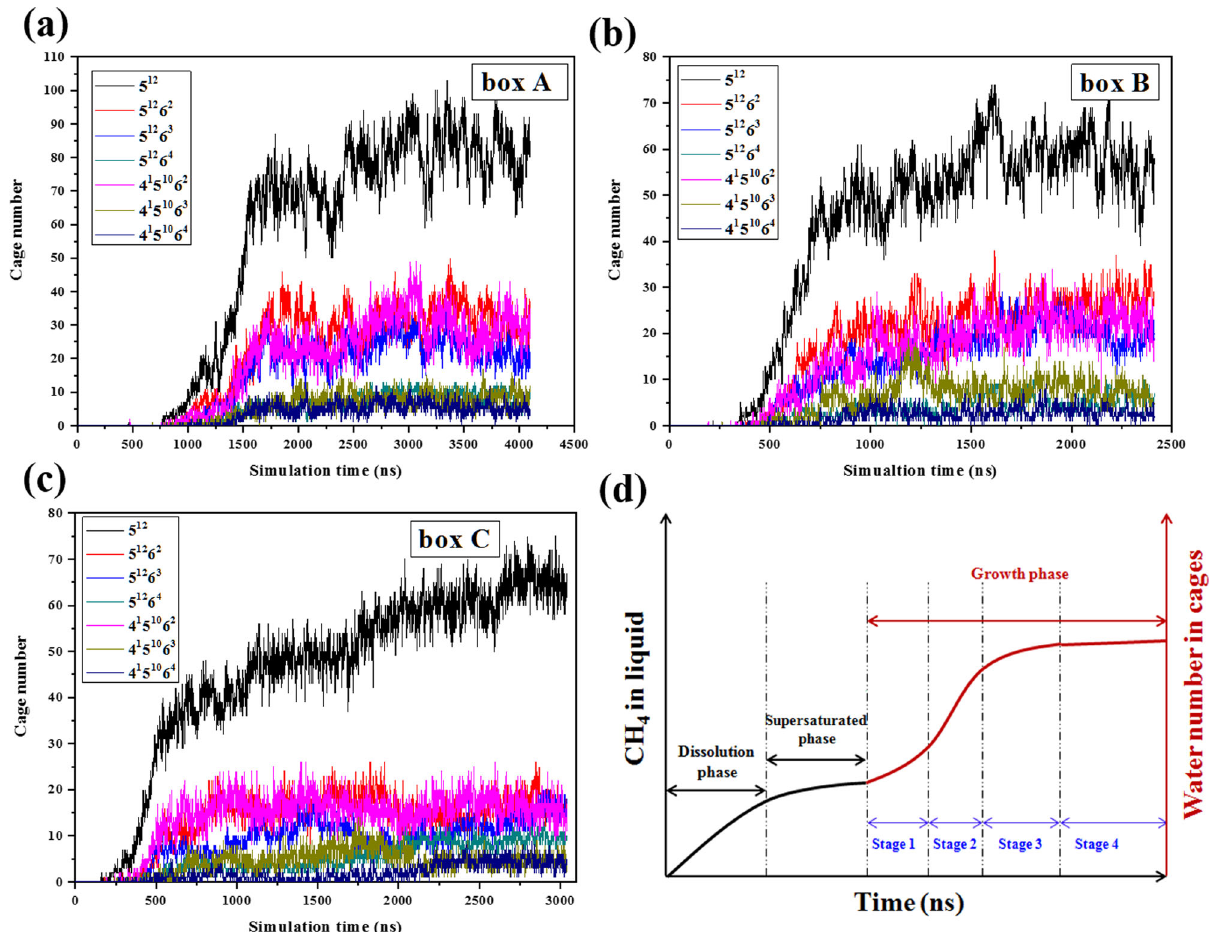
Fig. 3 Hydrate cage number evolution with time and different hydrate growth stages. a – c The change of hydrate cage numbers for simulation boxes A – C. d An illustration of different stages for hydrate nucleation and growth. Stage 4 denotes no more hydrate